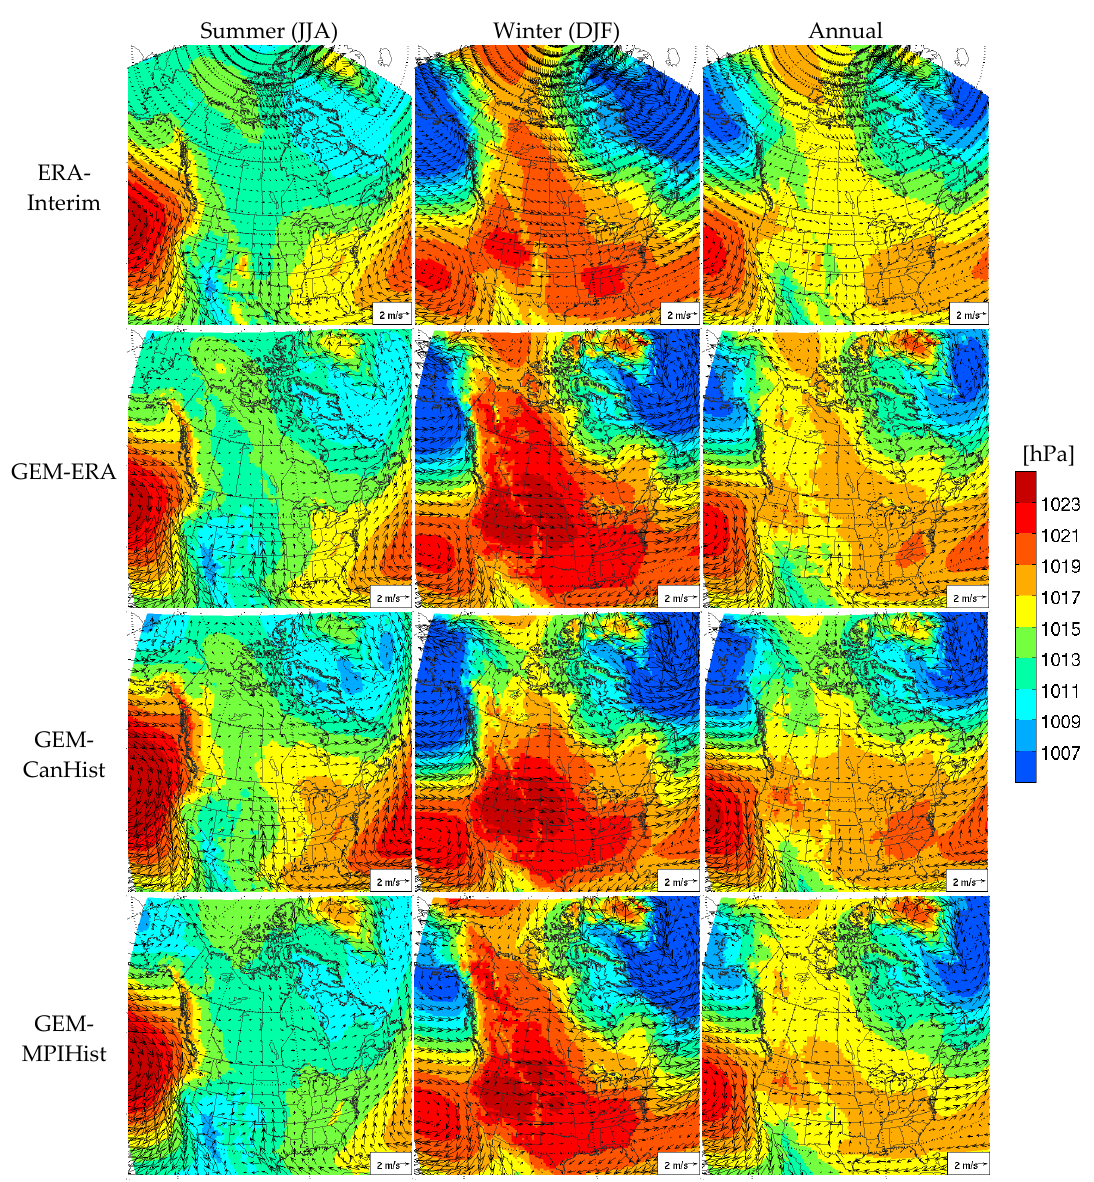
Figure 1. Summer (JJA), winter (DJF), and annual mean wind vector (arrow) and mean sea level pressure for ERA-Interim and three GEM model simulations (i.e., GEM-ERA, GEM-CanHist, and GEM-MPIHist) over North America for the 1981–2010 period.